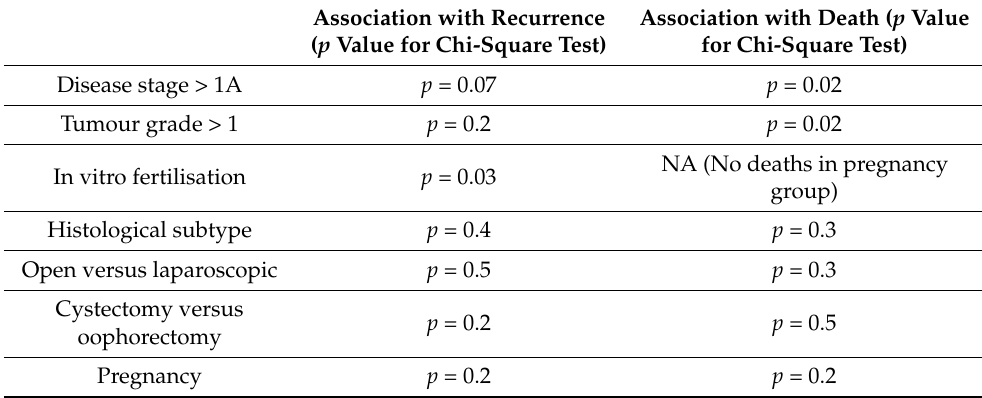
Table 3. Summary of potential risk factors and association with recurrence and